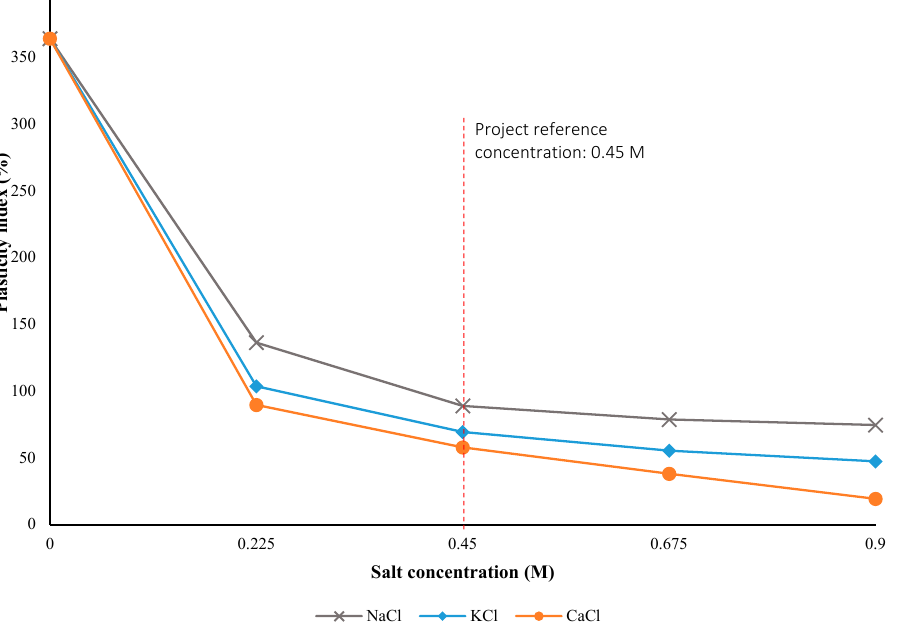
Figure 8. PI vs. Saline solution concentration batch 1 tests (Dotted line indicates reference salinity).